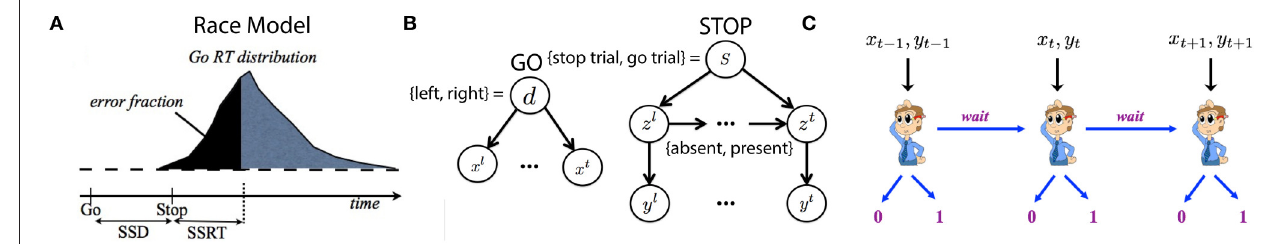
FIGURE 2 | Model illustration. (A) Classical race model for behavior in the stop-signal task. The behavioral outcome (go or stop) is determined by a race between a go and a stop process. The go reaction time has a broad distribution due to noise. The stop process has an average delay known as the stop signal reaction time (SSRT). The stop error rate is the cumulative density of Go RT at SSD + SSRT. The SSRT is thus estimated from data as the difference between the median go RT and the SSD at which 50% stop error is achieved, as SSD + SSRT = median(go RT) implies 50% of stop trials will end in error (the rest in success). (B) Bayesian generative model of iid sampled sensory observations ( x 1 ,..., x t ,... ) conditioned on Go stimulus identity ( d = 0 of left, d = 1 for right), and an independent stream of observations ( y 1 ,..., y t ,... ) conditioned on the presence ( z t = 1 ) or absence ( z t = 0 ) of the Stop signal, which has a geometrically distributed onset time when it is a stop trial s = 1 and never appears on a go trial ( s = 0 ). (C) The decision of whether/when to Go, and which Go response to select, are modeled as sequential decision-making, where the subject chooses at each moment whether to select a Go response, or to wait at least one more time point.